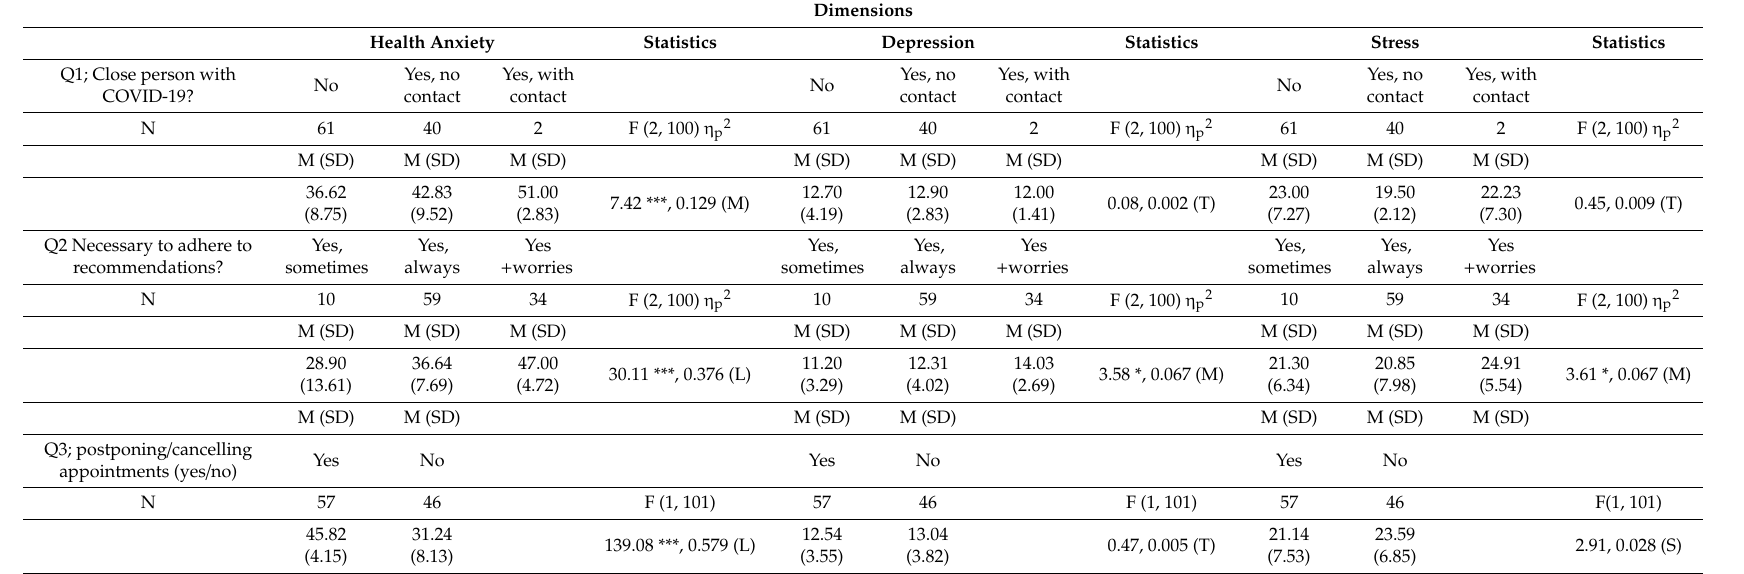
Table 3. Health anxiety, depression, and stress, depending from COVID-19-related questions. Dimensions Health Anxiety Statistics Depression Statistics Stress